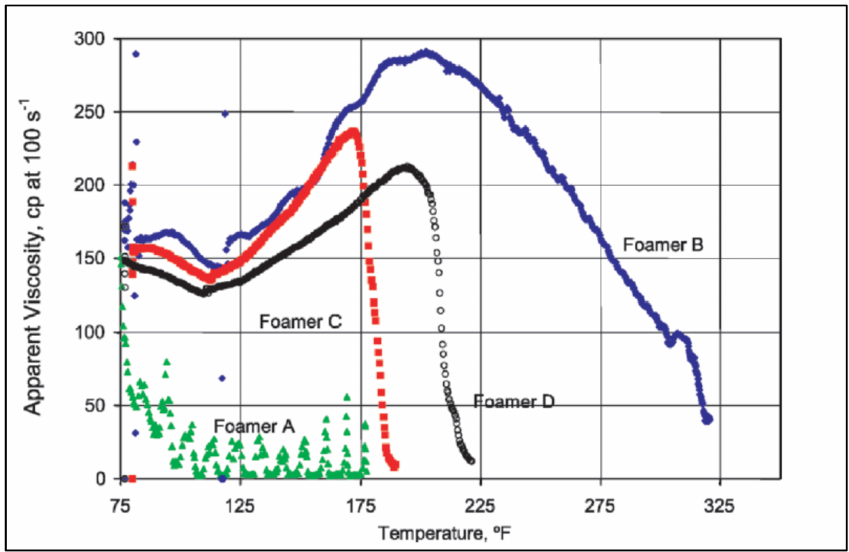
Figure 9. The change in foam viscosity as temperature increases (Reprinted with the permission from Hutchins & Miller, [29]). Copyright 2005, Society of Petroleum